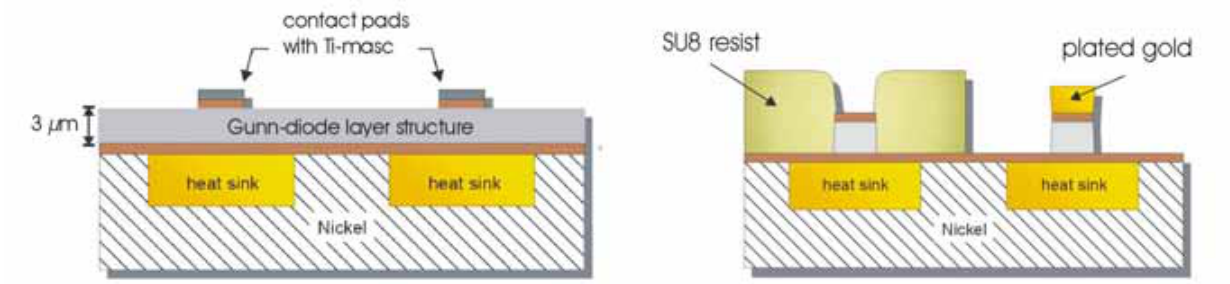
Figure 3. Sketch of the top contact definition, mesa ECR-RIE and top Au